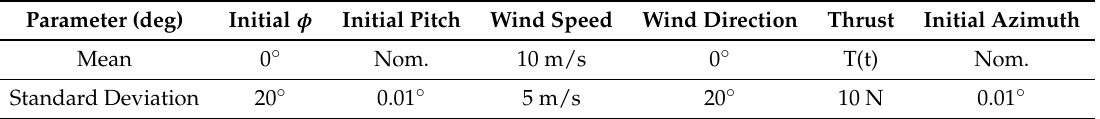
Table 6. Monte Carlo simulation parameters.